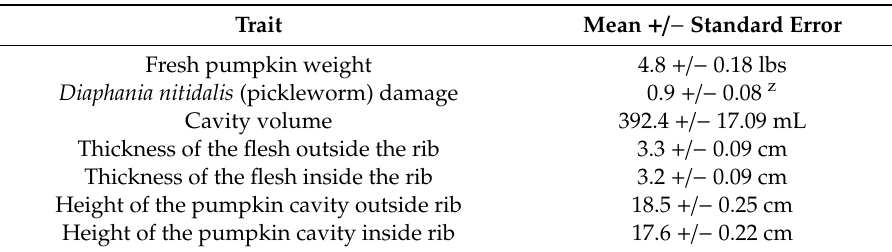
Table 2. Traits measured in the BC 1 population.